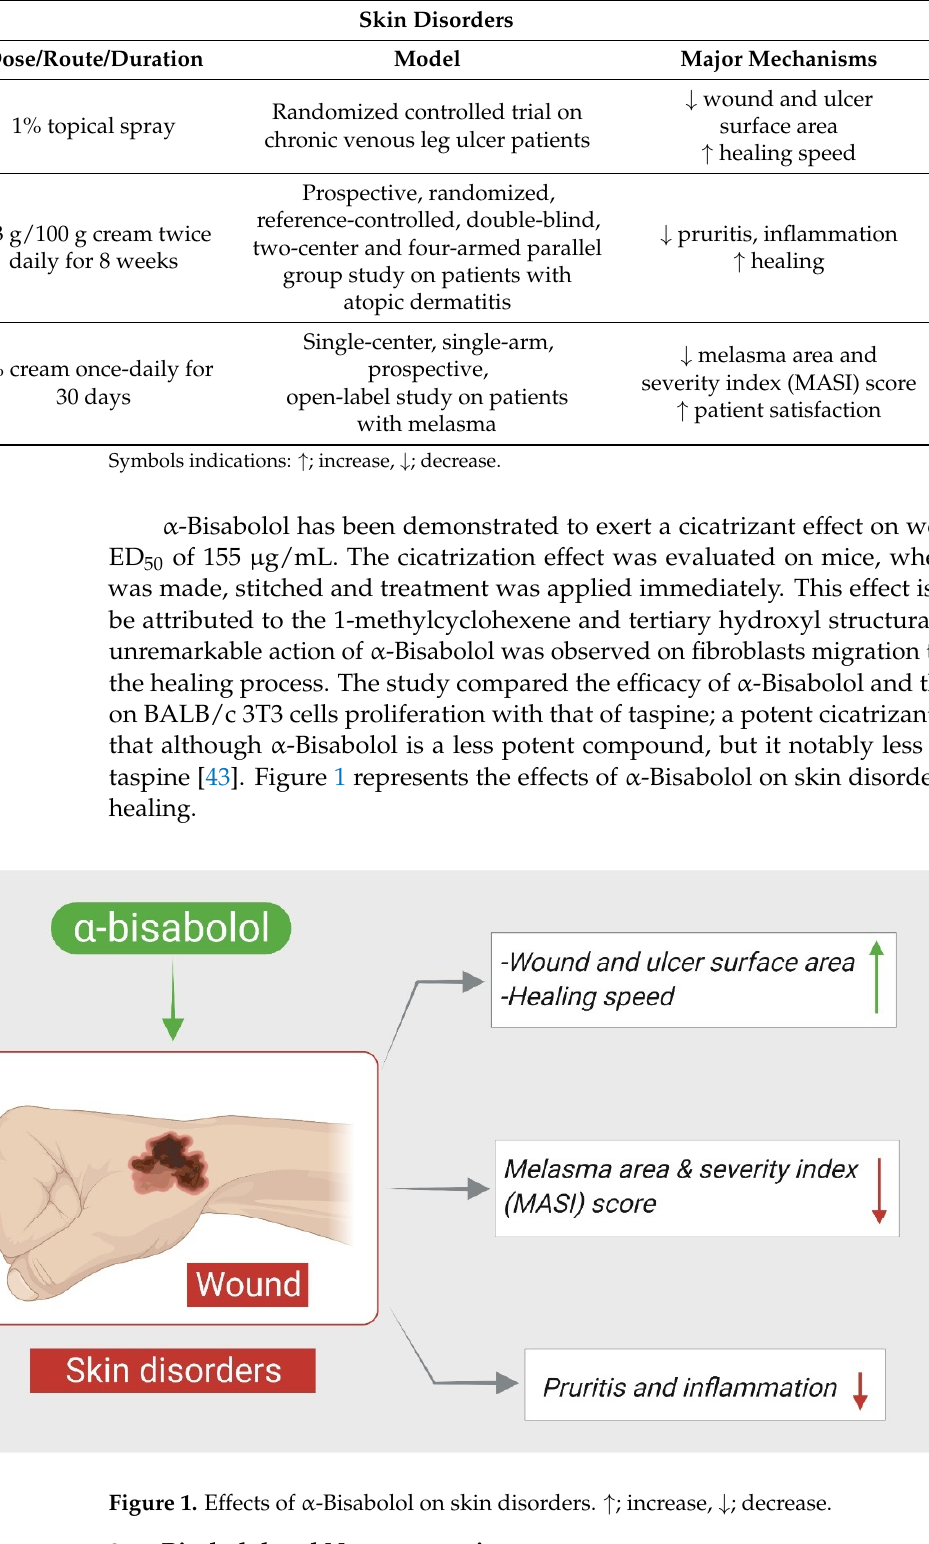
Figure 1. Effects of α‐ Bisabolol on skin disorders.  ; increase,  ;decrease.